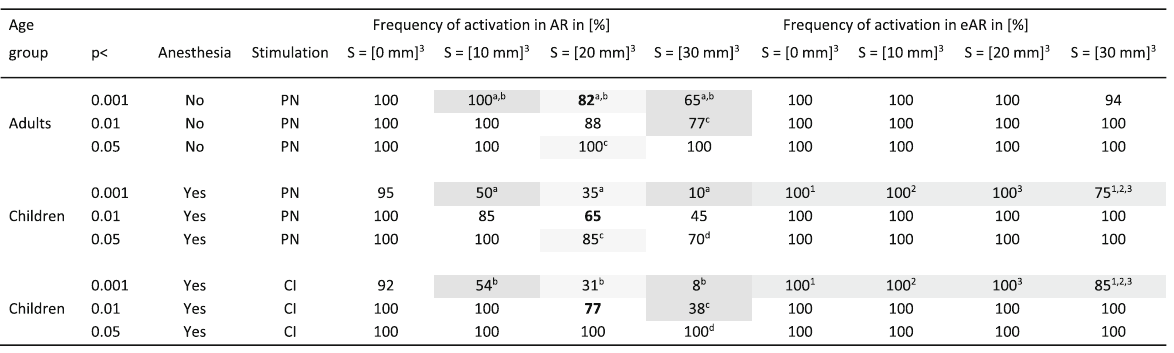
Table 4 Frequency of activations in AR and eAR – dependency on selected threshold for statistical inferences and applied smoothing filter-kernel. Frequency of activation in AR around 65 – 82% were reached with p < 0.001 for studies without anesthesia and p < 0.01 for those with anesthesia (bold, S = [20 mm] 3 ). Gray background indicates which values have been compared with respect to significance of difference (explicitly assigned by